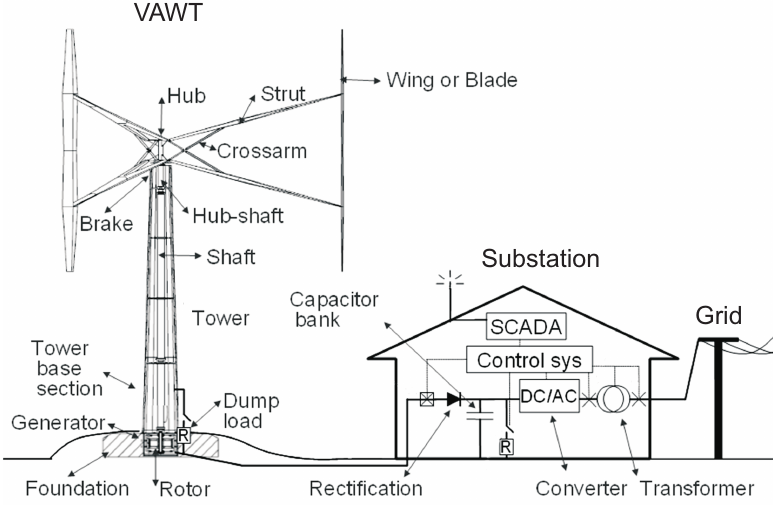
Figure 3. Converter system for the 200 kW VAWT.